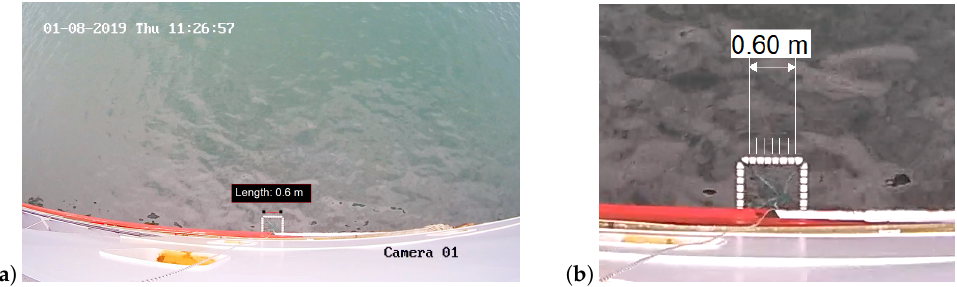
Figure 6. Floating frame for the calibration procedure: camera frame ( a ); zoomed view ( b